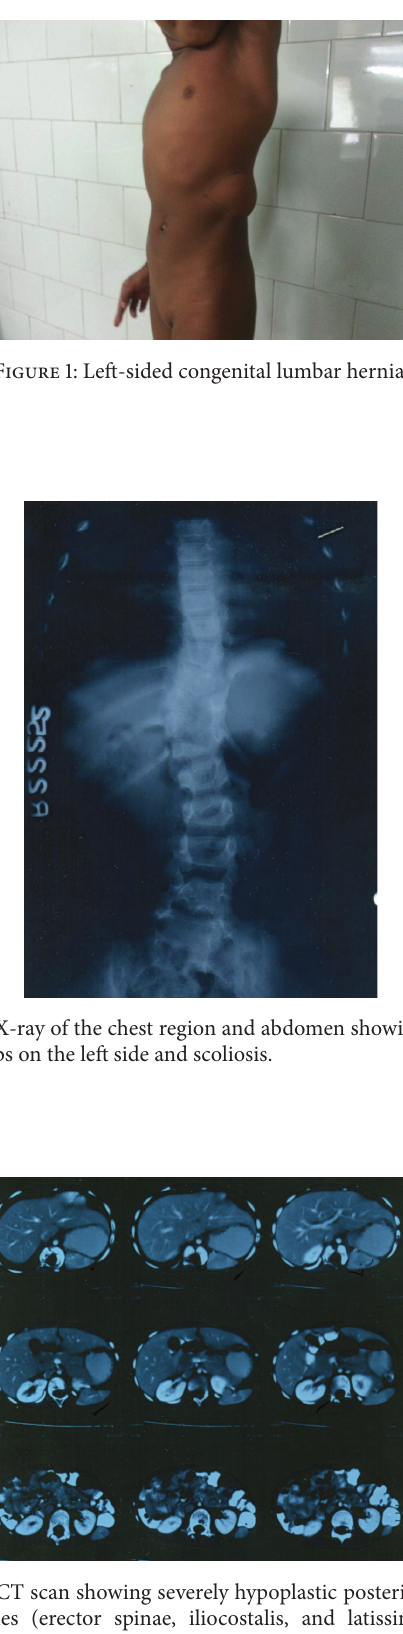
Figure 7: The defect closed over the mesh with overlapping flaps of the adjacent